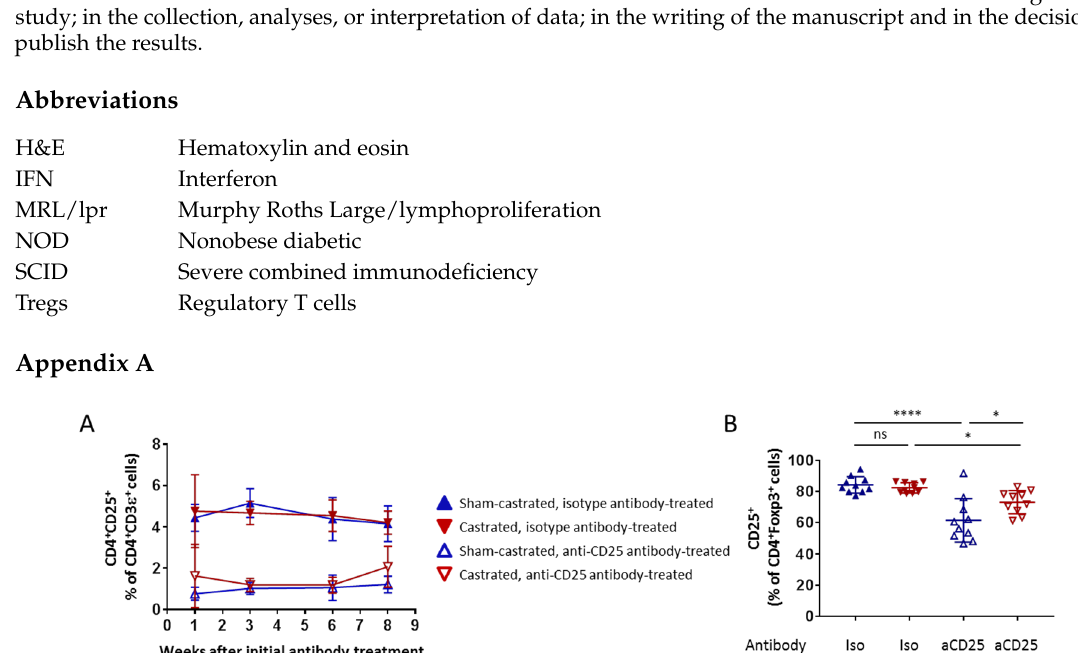
and Figure S1A at take-down (10 weeks after initial antibody treatment). Symbols represent individual mice, lines are means, and error bars are standard deviations. p <0.0001 by one-way ANOVA with individual comparisons corrected for multiple comparisons by Holm-Sidak as indicated: * p <0.05, **** p <0.0001, ns p >0.05. Abbreviations: aCD25, anti-CD25; Iso, isotype; Castr, castrated; Sham, sham-castrated.